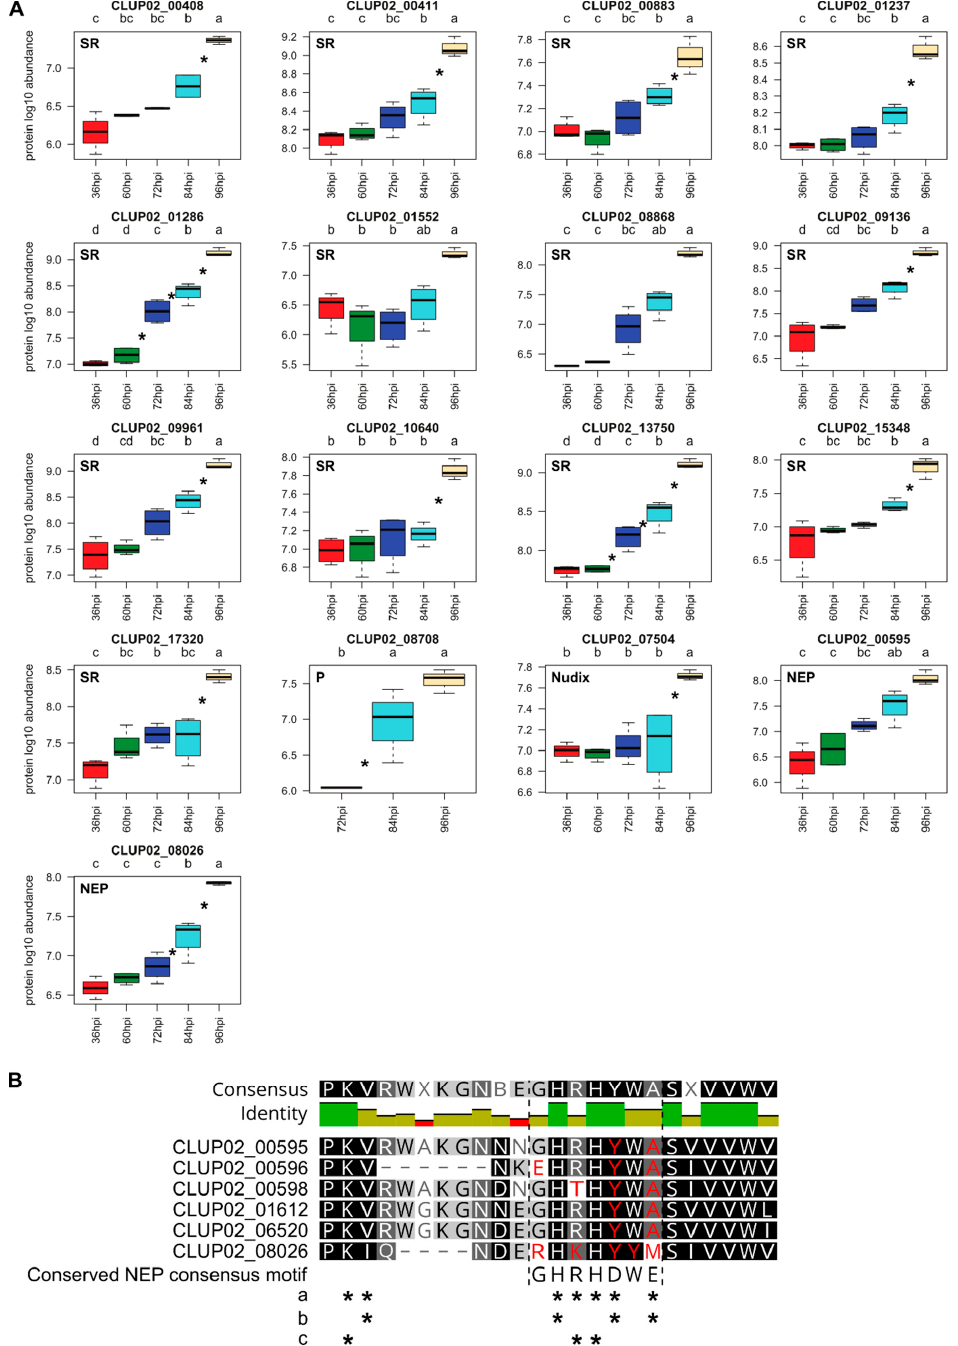
Figure 9. Abundance of representative pathogenesis-related proteins from C. lupini (Nudix, NEP, stress responses (SR) and other pathogenicity proteins (P)) across the infection kinetics. Boxplots show the mean abundance of pathogenesis-related proteins from four biological repetitions quantified by mass spectrometry. Asterisks between histograms indicate significant changes over time ( A ). Alignment of the protein sequences of the six NEPs differentially expressed in C. lupini during infection. The conserved amino acid residues were represented in green on the identity bar. Residues di ff erent from the conserved NEP pattern were identified in red. Asterisks indicate residues characterized as crucial for NEP activity (a), amino acid residues by alanine replacements resulting in abolished (b) or reduced (c) activity [14,73] ( B